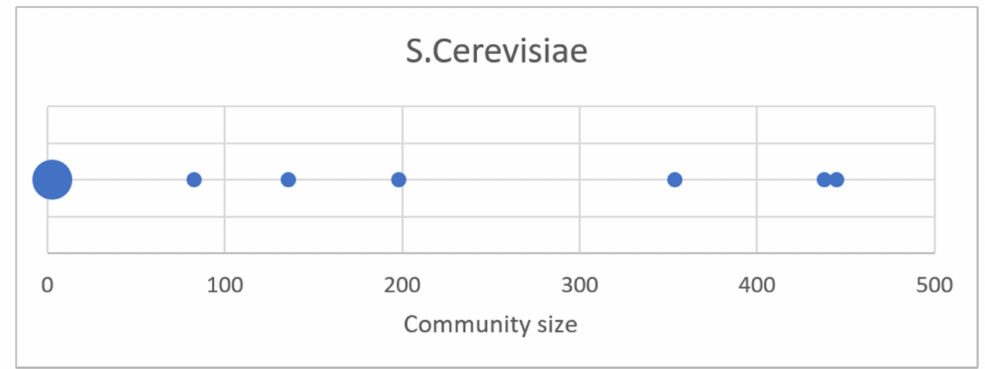
Figure 8. The size of the communities found in Saccharomyces cerevisiae (the larger dot indicates the presence of the small size